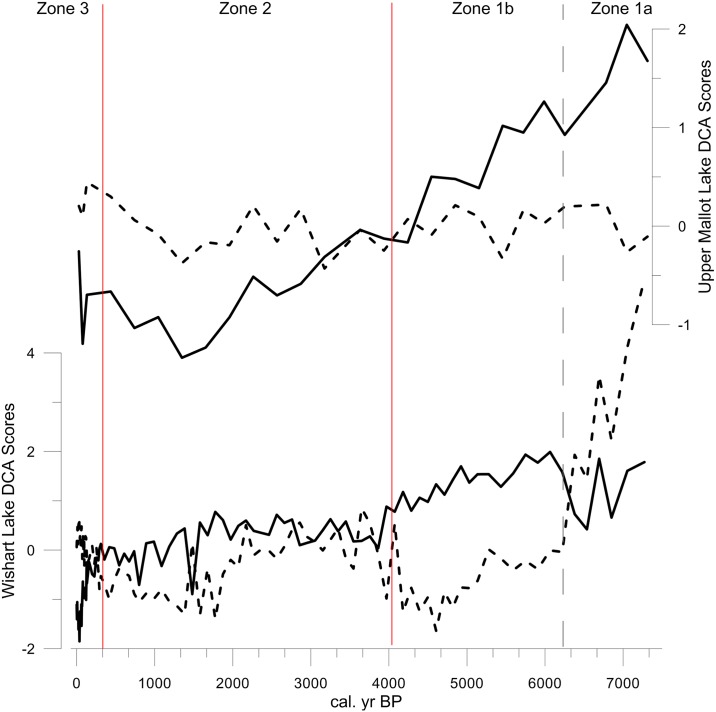
Ordination results for Wishart Lake diatoms and Upper Mallot Lake pollen assemblages.Detrended Correspondence Analysis axis 1 (solid lines) and axis 2 (dashed lines) for Wishart Lake diatom record (lower panel) and for the past ~7200 cal. yr BP Upper Mallot Lake pollen record (upper panel; raw pollen data from ref. [20] and publicly archived at neotomadb.org). Red lines delineate Wishart Lake diatom zones from cluster analysis; dashed grey line indicates the subdivision of Zone 1. Analysis and diagram generated using the rioja package for R [62].